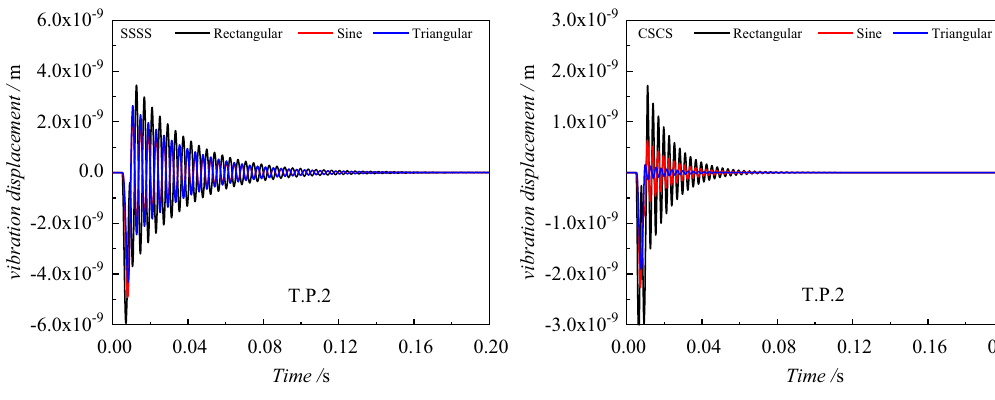
Figure 18: Comparison of the damped transient vibration with di ff erent types of time - dependent